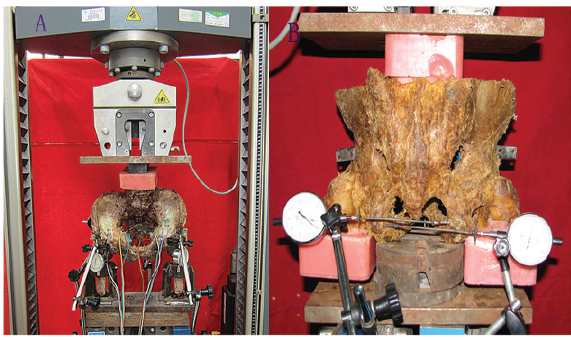
Figure 2 - Tests in the pelvis. (A. front, B. back).